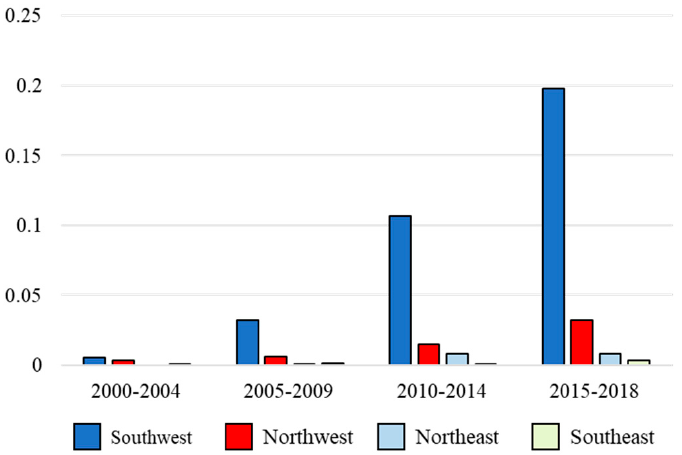
Figure 5. Evolution of the average innovation capacity of the tertiary industry of the units in each area in Shenzhen from 2000 to 2018.